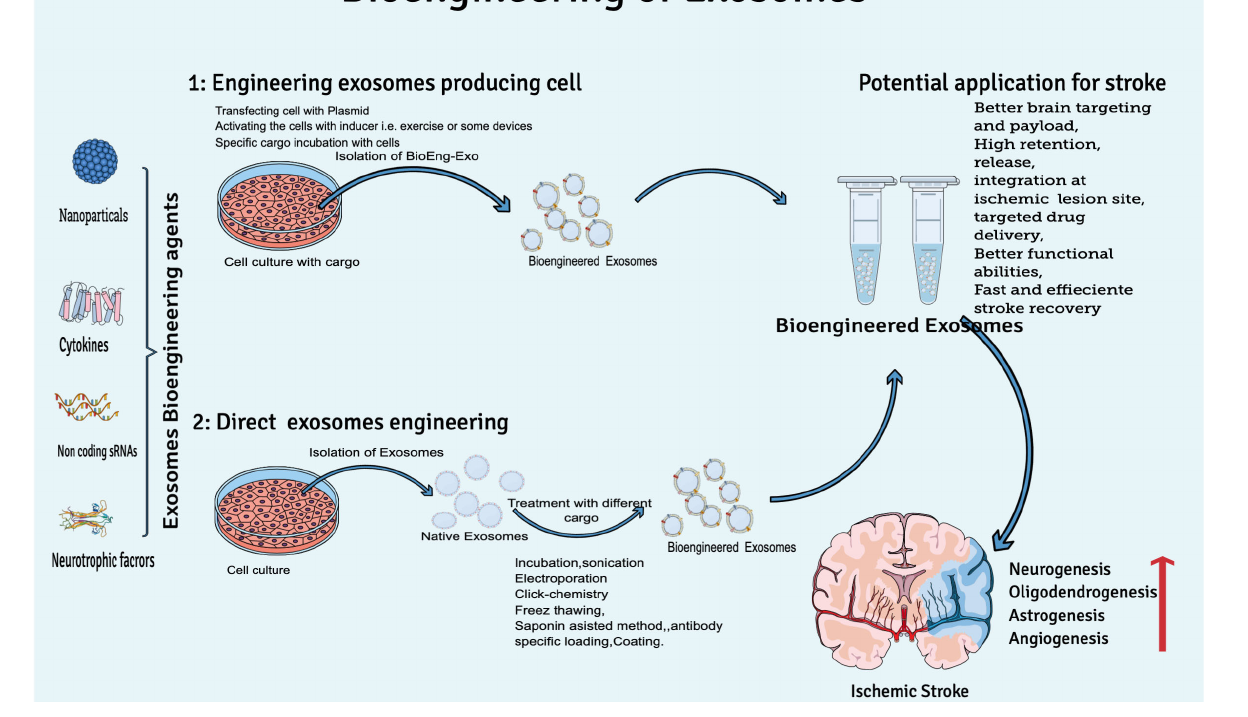
FIGURE 3 | Overview of exosome bioengineering for better ischemic stroke therapy. Two basic approaches used for exosomes engineering are (1) engineering exosome-producing cells (transfecting, activating, or incubation of cargo with cells) and (2) direct exosome engineering (by loading or decorating specific cargo to exosomes after